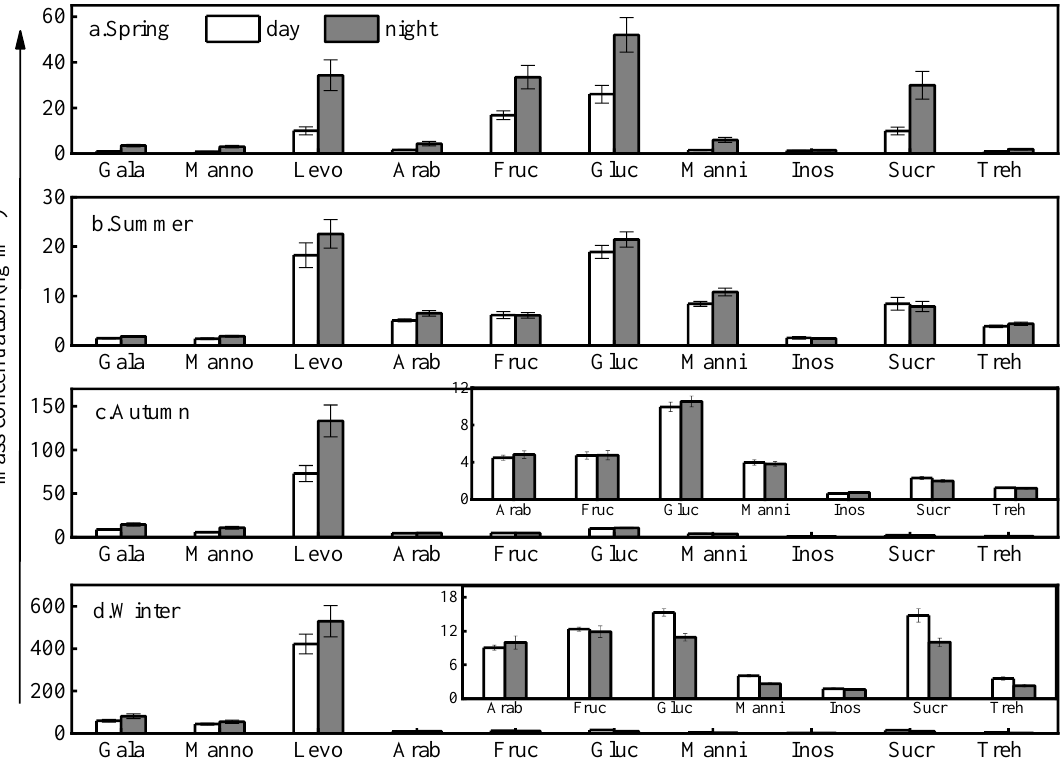
Figure 2. Seasonal and daily variations of carbohydrate mass concentrations (error bars represent min. – max. concentrations).